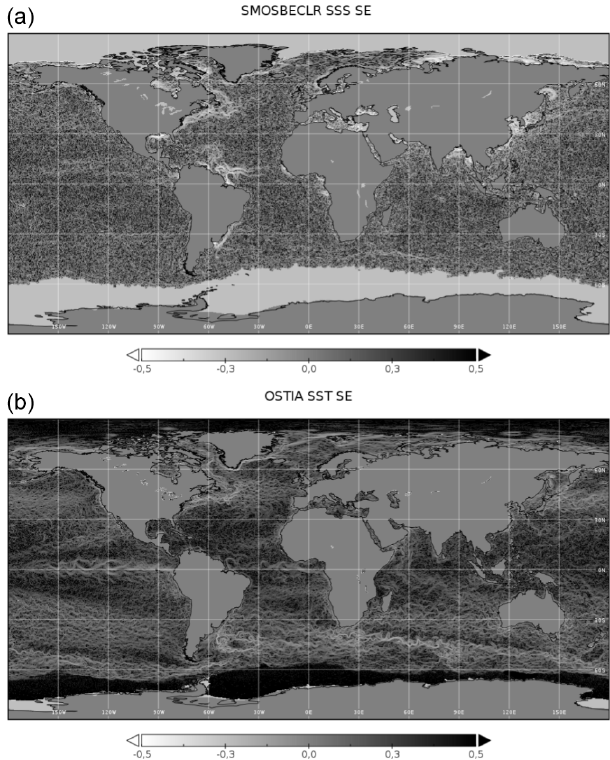
Figure 4. SE for the 15 August 2017. (a) SE of BEC LR SSS prod- uct. (b) SE of OSTIA